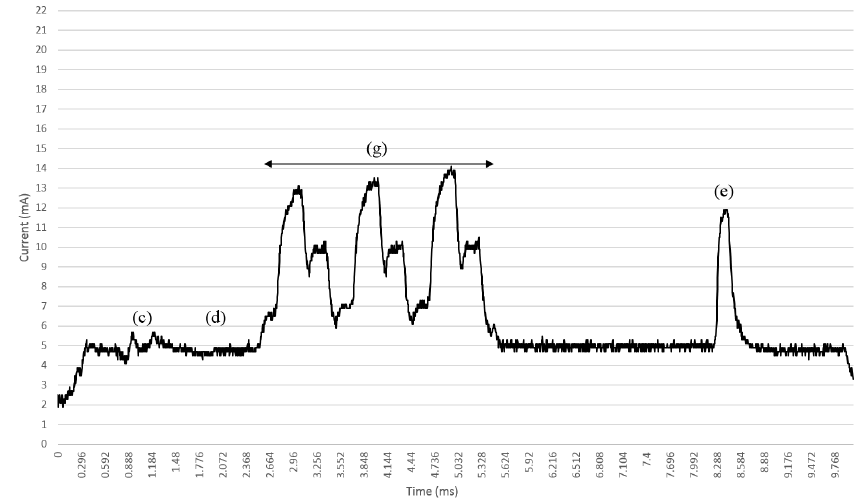
Figure 6. Use of the scheduler concept to delay the FLASH write current to run after the BLE ADV transmission has occurred. Point (e) has now been delayed 5 ms to after the start of point (g), separating the large current into two processes constraining the peak